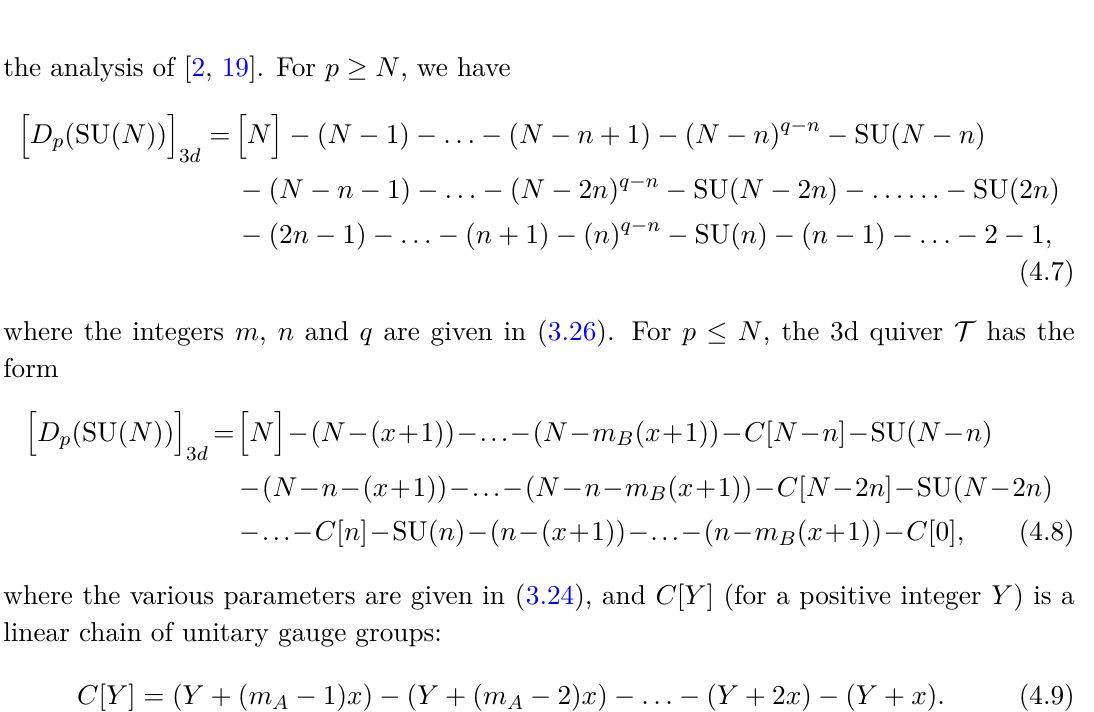
amounts to adding a single hypermultiplet P